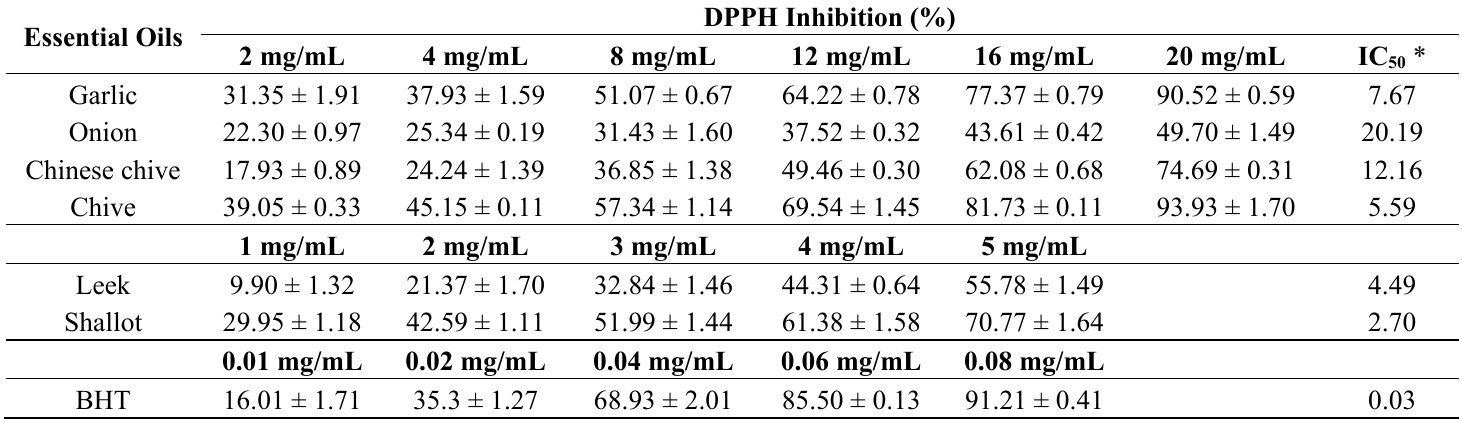
Table 4. Antioxidant activity of garlic, onion, leek, Chinese chive, shallot, chive EO and BHT at different concentrations measured by DPPH